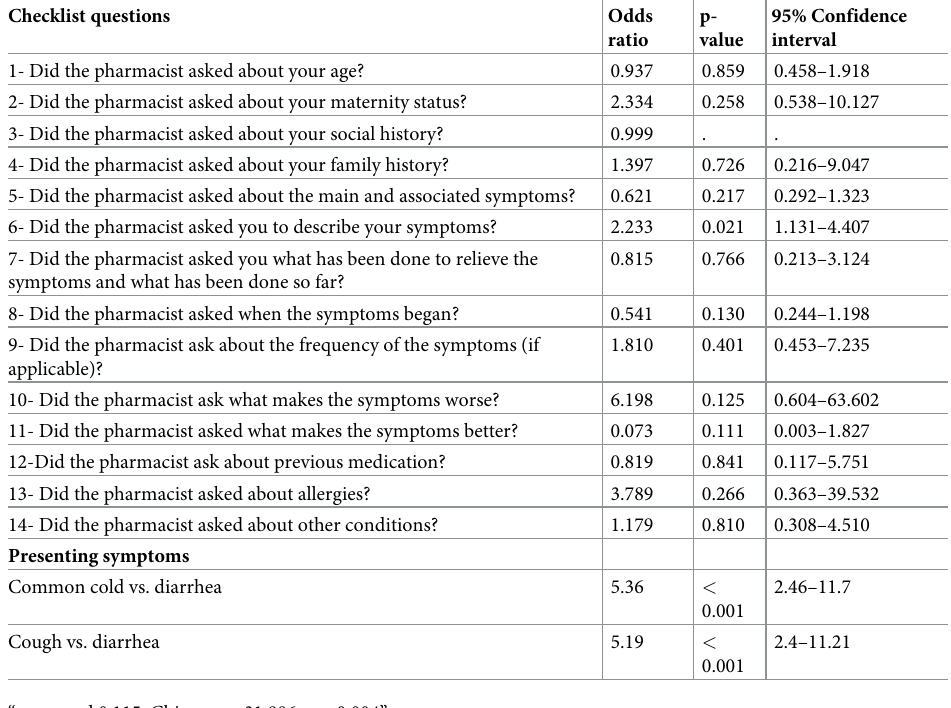
Table 4. Relationship between checklist questions and the provision of OTC medications according to